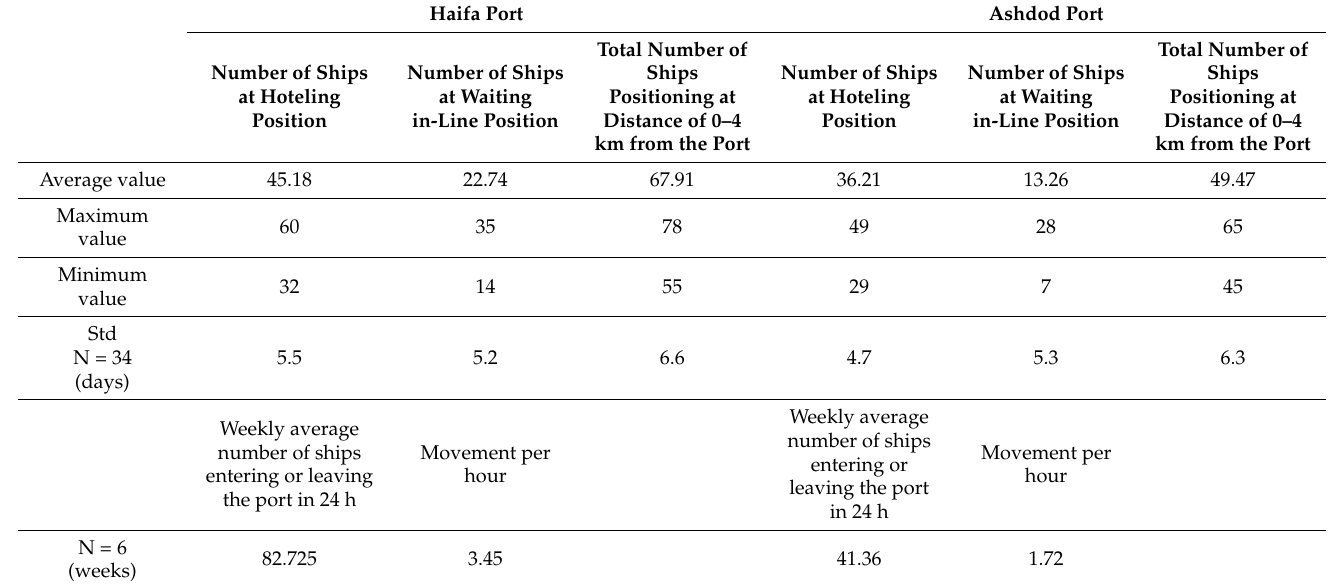
Table A7. Summary of ships tracking of typical movements and location around the ports for